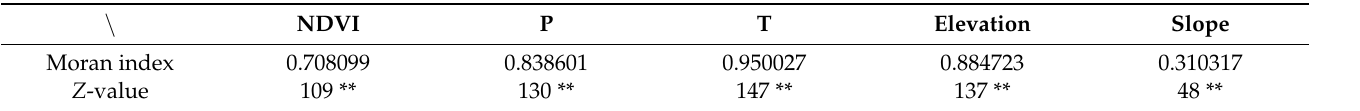
Table 4. Moran’s I and Z scores of regression coefficients for each factor in the geographically weighted regression